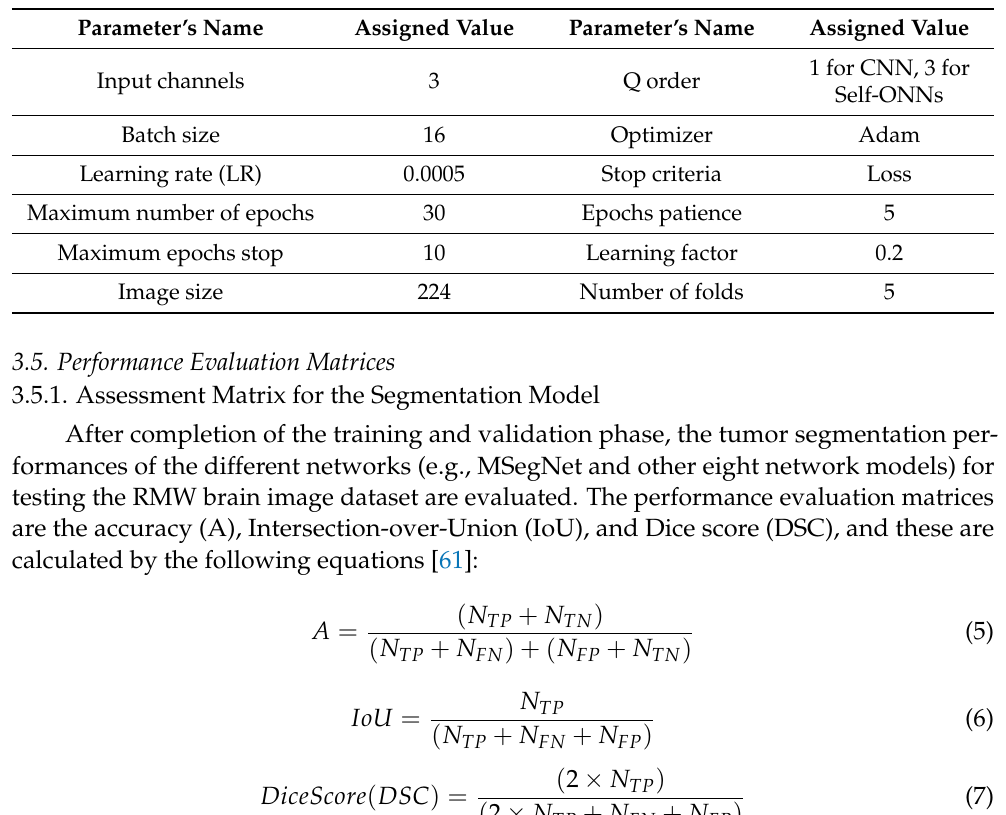
Table 5. Hyper-parameters for all classification